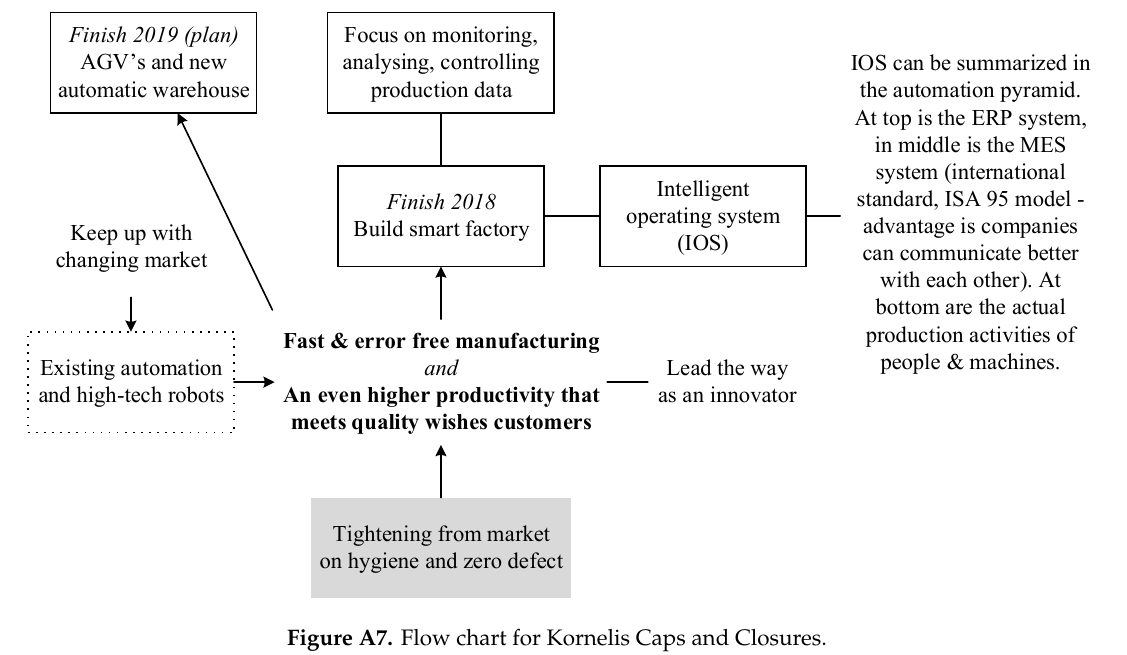
Figure A6. Flow chart for Itter.